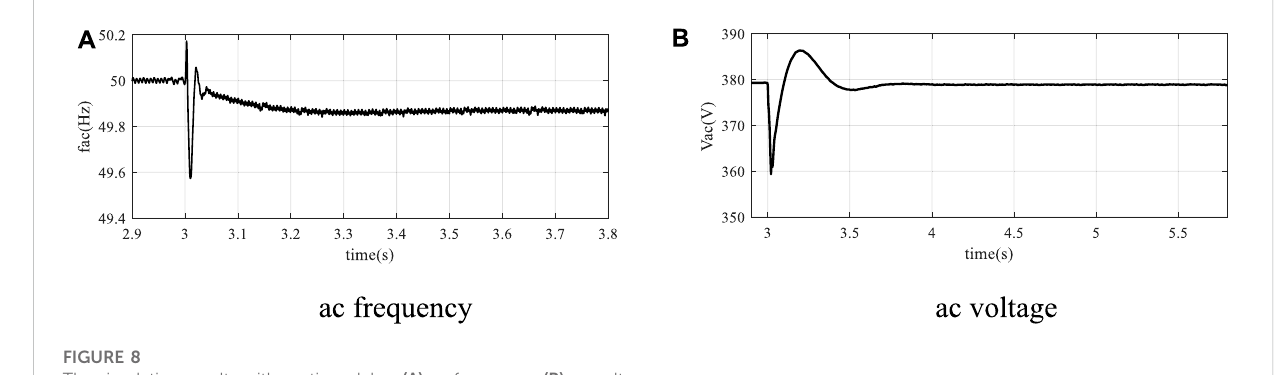
FIGURE 8 The simulation results with no time delay. (A) ac frequency, (B) ac